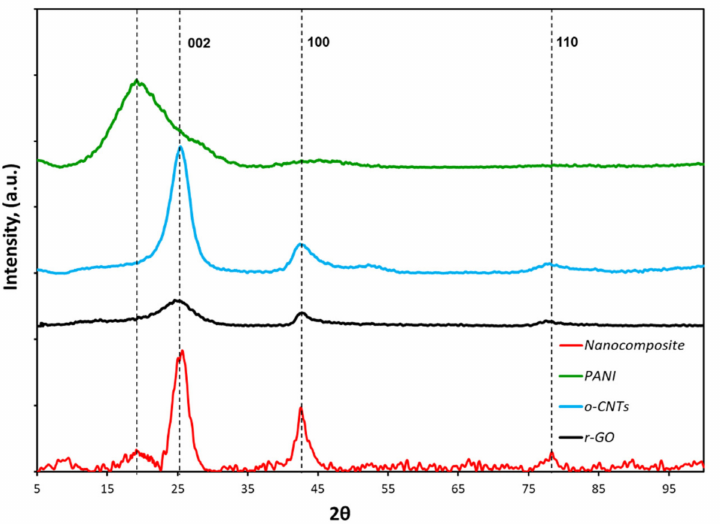
Figure 2. XRD-pattern of the initial materials and the r-GO/o-CNTs/PANI nanocomposite